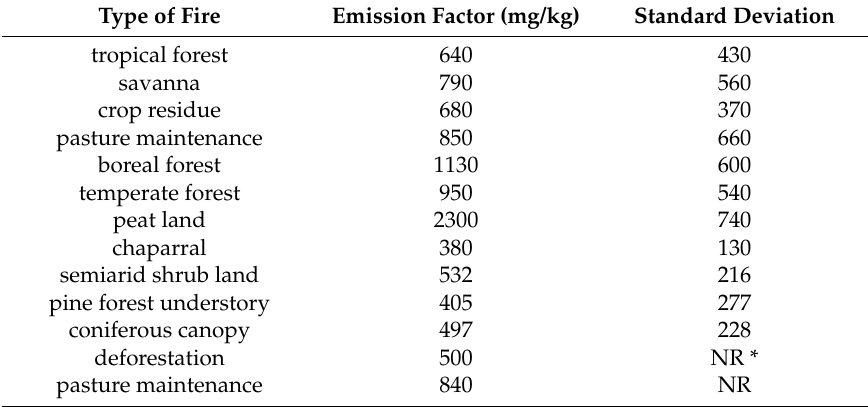
Table 1. Biomass fire emission factors compiled from studies conducted both in the field in the laboratory